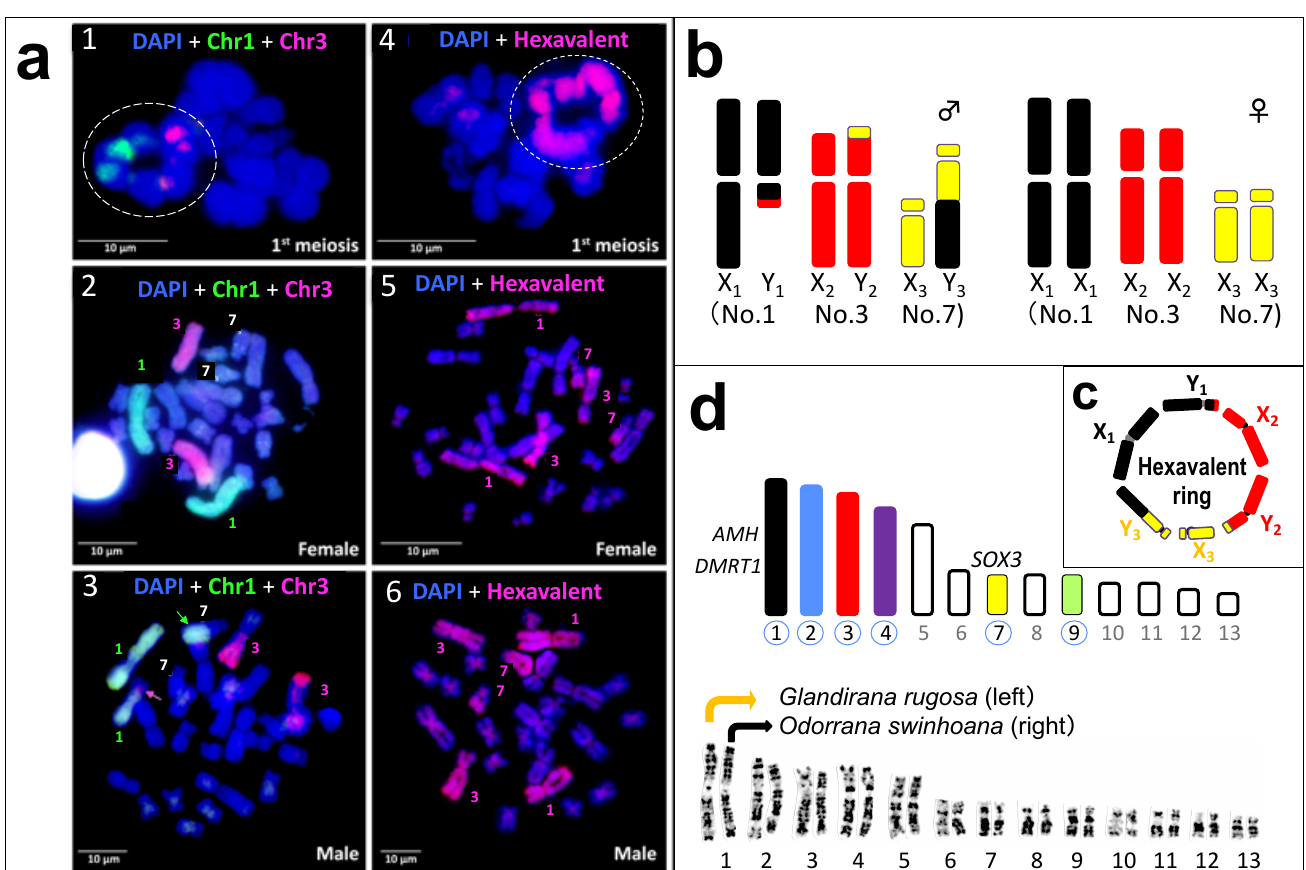
Figure 2. Chromosome painting and diagrams showing the multiple sex-chromosomes and potential sex-chromosomes. Hybridization with probes of microdissected chromosomes 1 (green) and 3 (red) onto the 1st meiotic chromosomes and somatic chromosomes of male and female ( a1 – a3 ). Chromosome 1 probe DNA is shown in green, while chromosome 3, in red. The hybridization with hexavalent probe (red) onto the 1st meiotic chromosomes and somatic chromosomes of male and female ( a4 – a6 ). Hexavalents are boxed by the white dotted line ( a1 , a4 ). Diagrams of six sex-chromosomes in males (left) and females (right) ( b ): chromosomal materials of No. 1, 3 and 7 are shown in black, red and yellow, respectively. The hexavalent is diagrammatically shown in ( c ). Thirteen haploid complements of ranid frogs, of which six potential sex-chromosomes are colored, and their chromosome numbers are circled (upper) ( d ). Orthologs of three sex-determining genes that are mapped in the Japanese frog G. rugosa are shown on the left or top of chromosomes 1 and 7, respectively. The late replication banding patterns of 13 chromosome complements are perfectly conserved between Glandirana rugosa and Odorrana swinhoana , shown at the